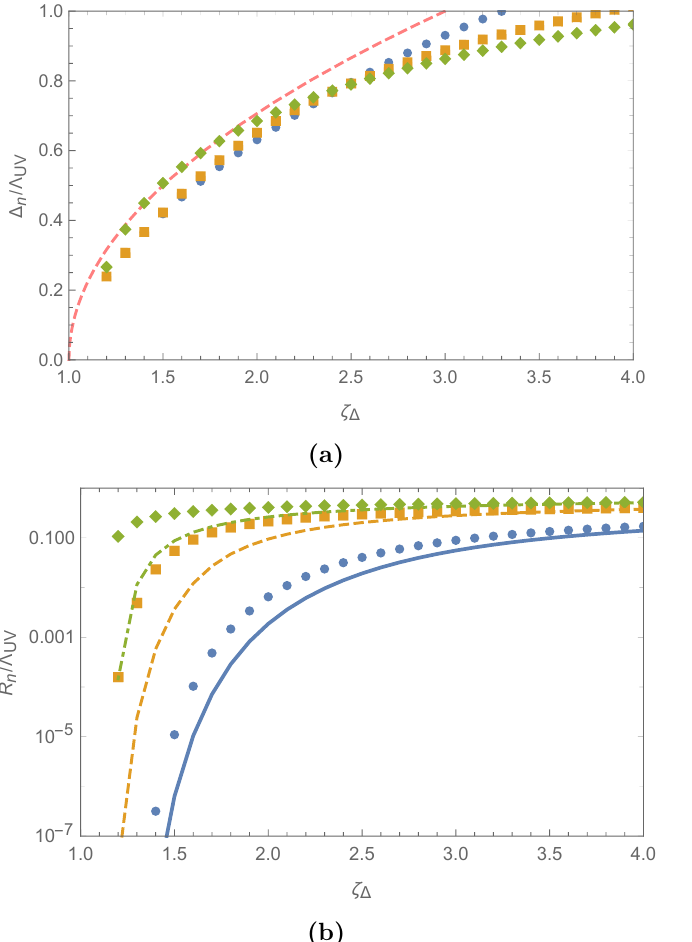
Figure 1. Numerical values for (a) ∆ n and (b) R m as functions of ζ ∆ in the regime ζ ∆ > 1 , ζ R < 1 . n The blue dots, yellow squares and green diamonds correspond to ζ R = 0 . 2 , 0 . 5 , and 0 . 8 , respectively. In (a), the dashed red curve represents the analytic approximation for ∆ n without mixing terms given in eq. (2.18). In (b), the blue (solid), yellow (dashed) and green (dot-dashed) curves represent the analytic approximation for R m given in eq. (2.19). This approximation works better for small n ζ R (lower